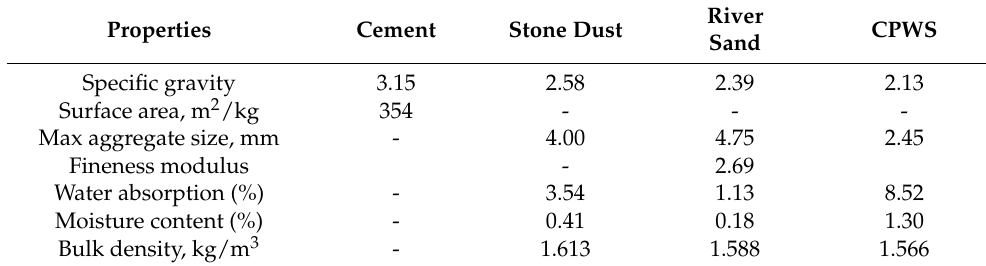
Table 4. Physical properties of constituent